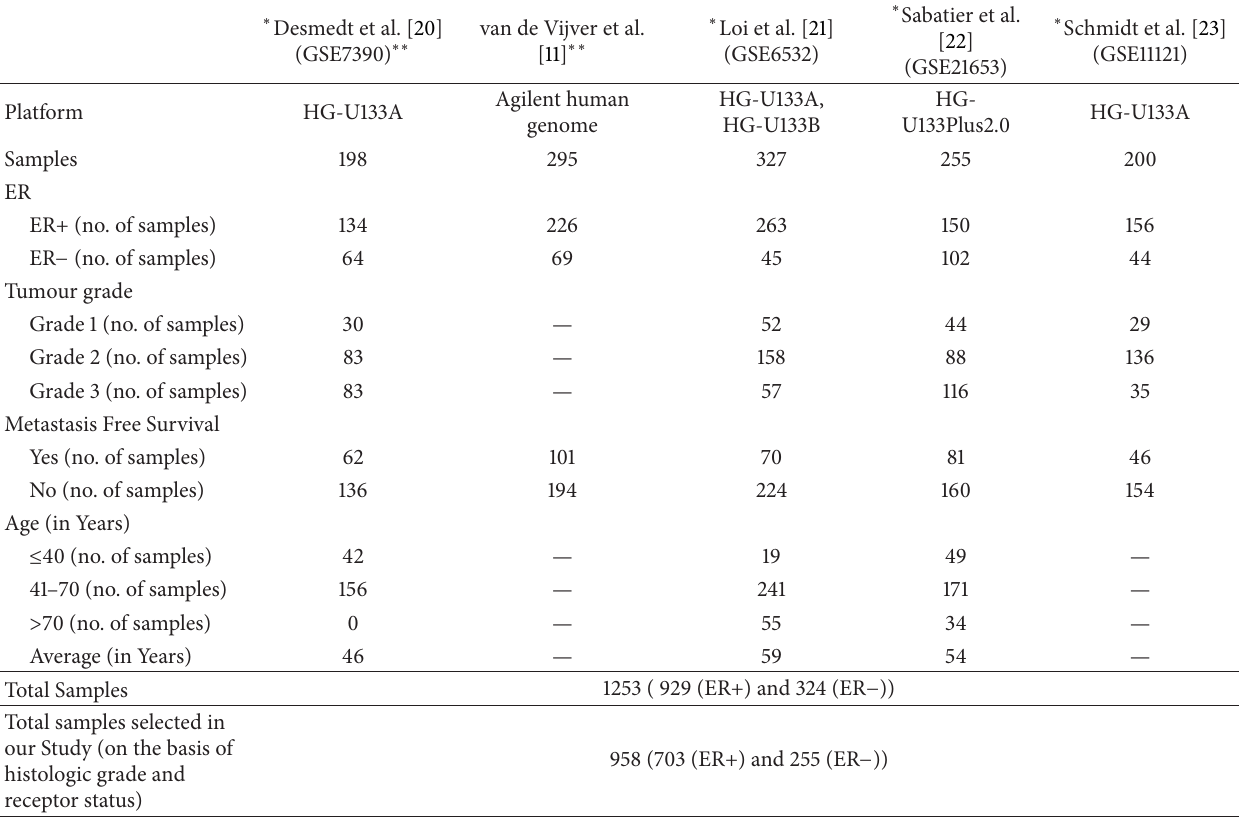
Table 1: Microarray datasets used in this